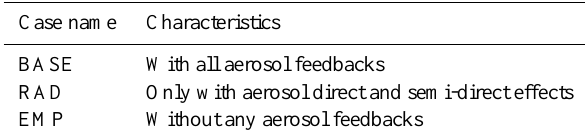
Table 1. Summary of three simulated